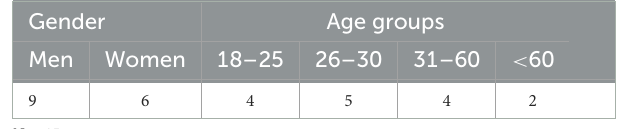
TABLE 2 Interview participant gender and